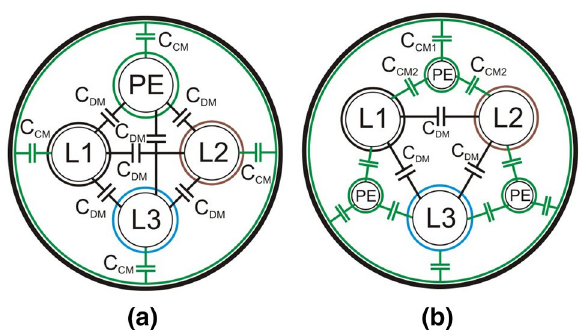
Figure 11. Cross-section of 3-phase screened cables with green marked parasitic line-to-line capacities C DM and parasitic ground leakage capacities C CM in: ( a ) with 1 PE wire, ( b ) with 3 PE